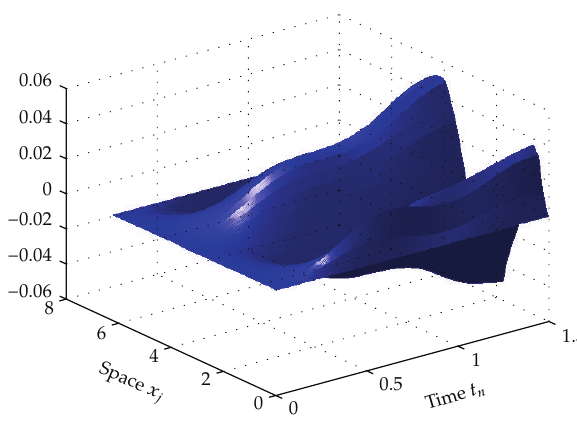
Figure 2: Conservative case, μ (cid:8) 3.